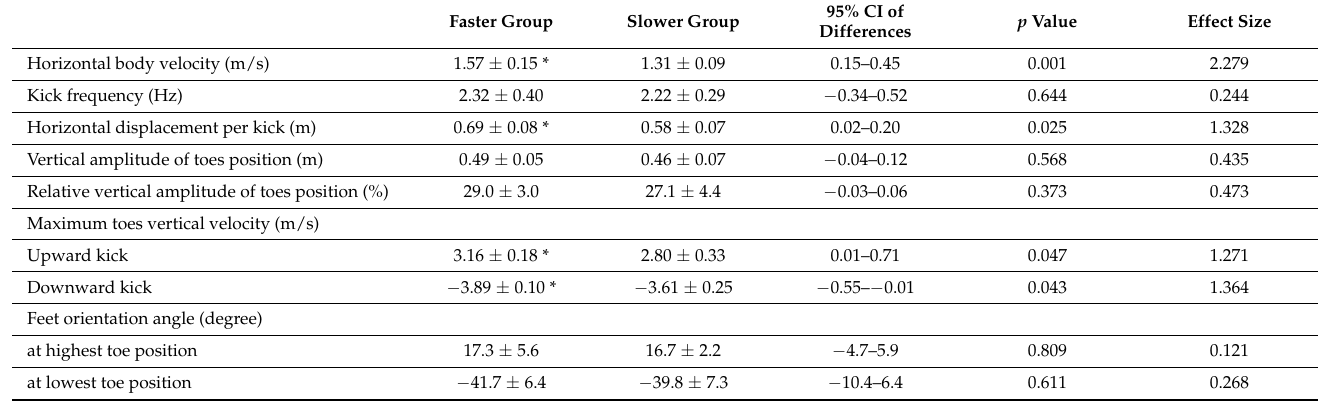
Table 2. The horizontal body velocity, kick frequency, horizontal displacement per kick, vertical amplitude of toes position, maximum toe vertical velocity, and foot orientation angle at the highest and lowest toe